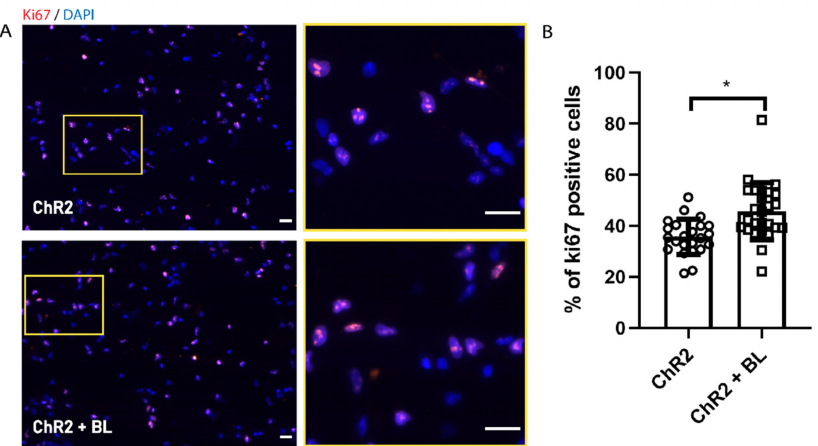
Figure 1. Optogenetic stimulation increases channelrhodopsin-2 (ChR2) in spinal cord-derived NPC (ChR2-NPC) prolif- eration. ( A ) Representative immunofluorescence images for the proliferation marker Ki67 (red) with nuclear staining by 4 (cid:48) ,6-diamidino-2-phenylindole (DAPI) (blue) in unstimulated (upper panels) and blue light (BL)-stimulated ChR2-NPCs (lower panels). Yellow square: Inset showing higher magnification. ( B ) Quantification of Ki67-positive ChR2-NPCs ex- pressed as the percentage of the total number of cells in unstimulated NPCs (ChR2) or BL-stimulated NPCs (ChR2 + BL) for three consecutive days. Data expressed as mean ± SEM from three independent experiments (ChR2: 34.8 ± 1.2; ChR2 + BL: